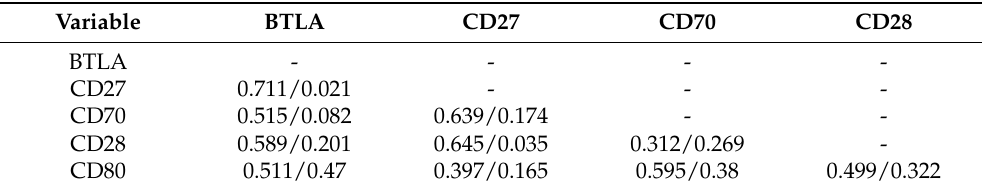
Table 8. The correlations between serum concentrations of BTLA, CD27, CD70, CD28 and CD80, presented as Spearman ranges‚ r correlation coefficient/ p -value. Variable BTLA CD27 CD70 CD28 BTLA - CD27